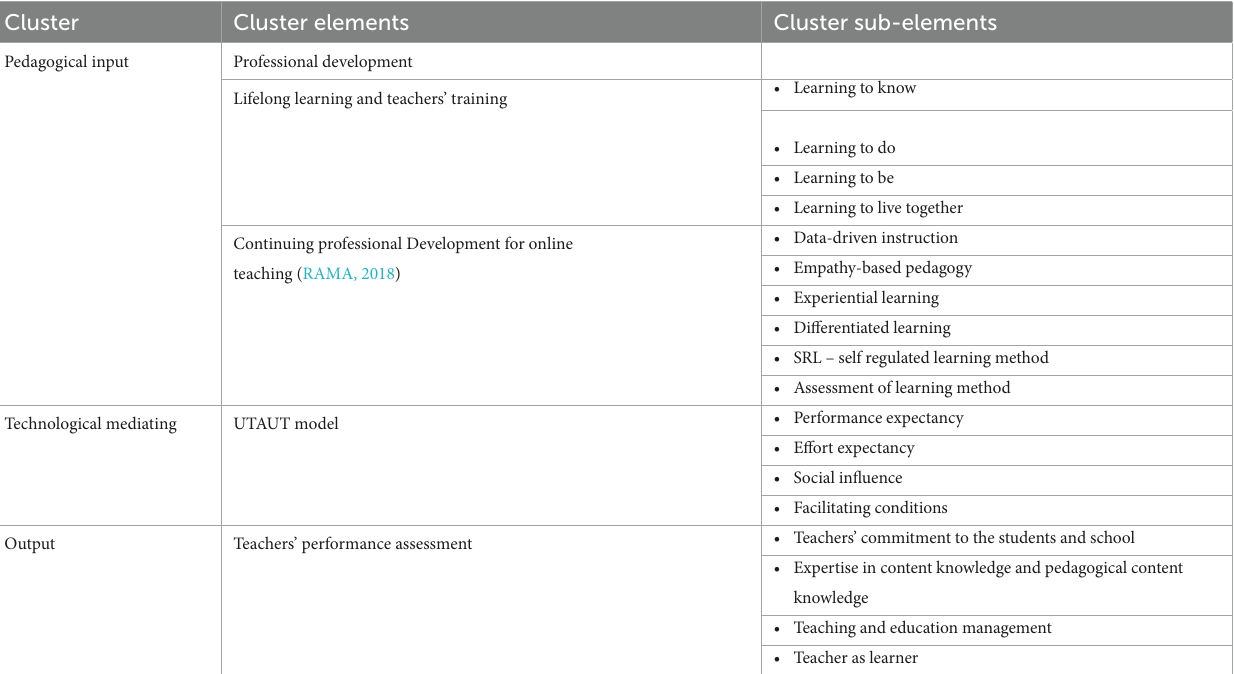
TABLE 1 Research